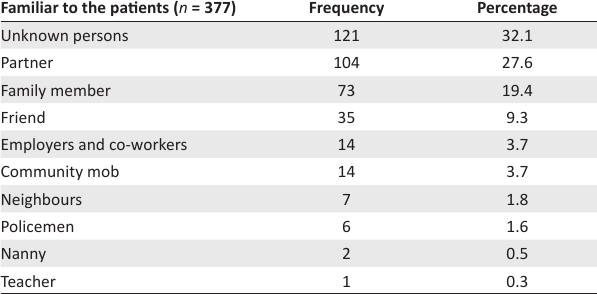
TABLE 3: The relationship between victims and